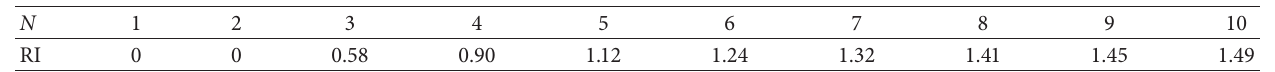
Table 8: The random consistency index (Saaty [36]).